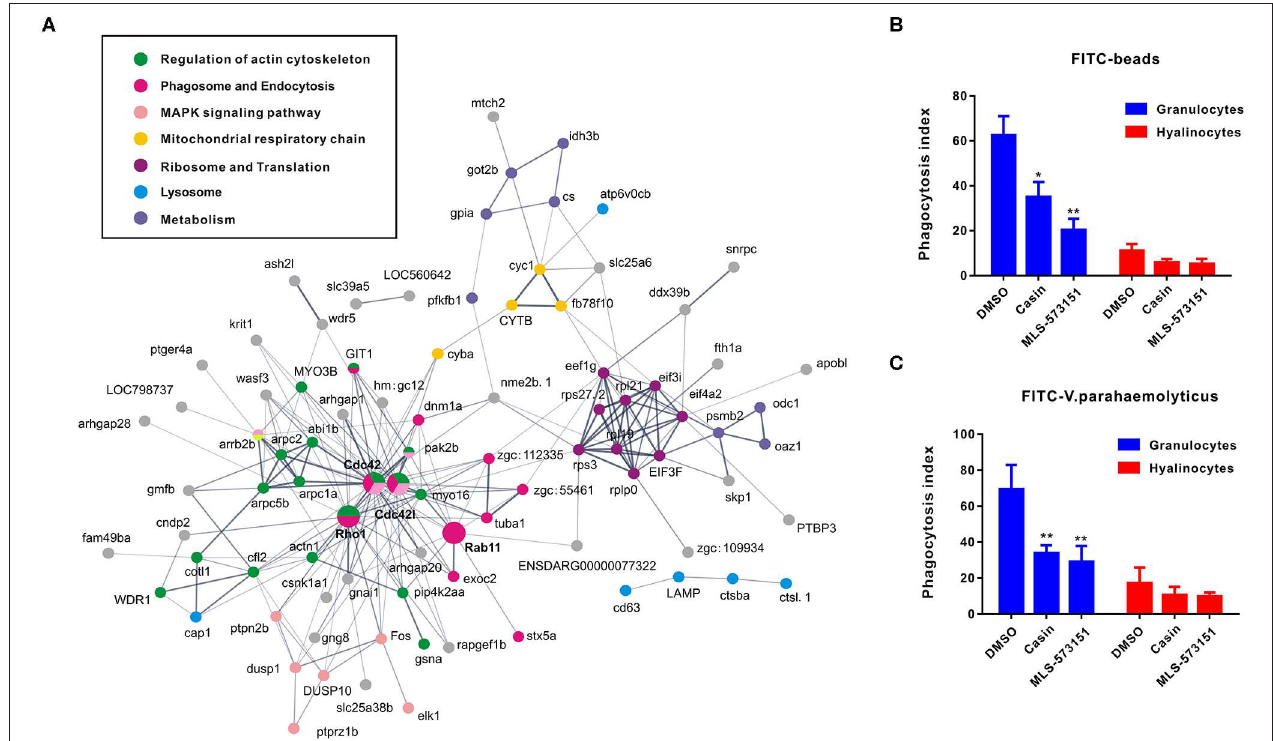
FIGURE 3 | Networks based on DEGs implicating central roles of Cdc42 in granulocyte phagocytosis. (A) Networks are represented here schematically. Nodes represent proteins. Edges represent interactions between proteins. Different colors represent different pathways and proteins. (B,C) Phagocytosis index of FITC beads (B) or FITC-labeled bacteria ( V. pa ) (C) by C. gigas granulocytes and hyalinocytes in the presence of Cdc42 inhibitors (casin and MLS-573151). Blue panel represents granulocytes and red panel represents hyalinocytes. * p < 0.05; ** p < 0.01.